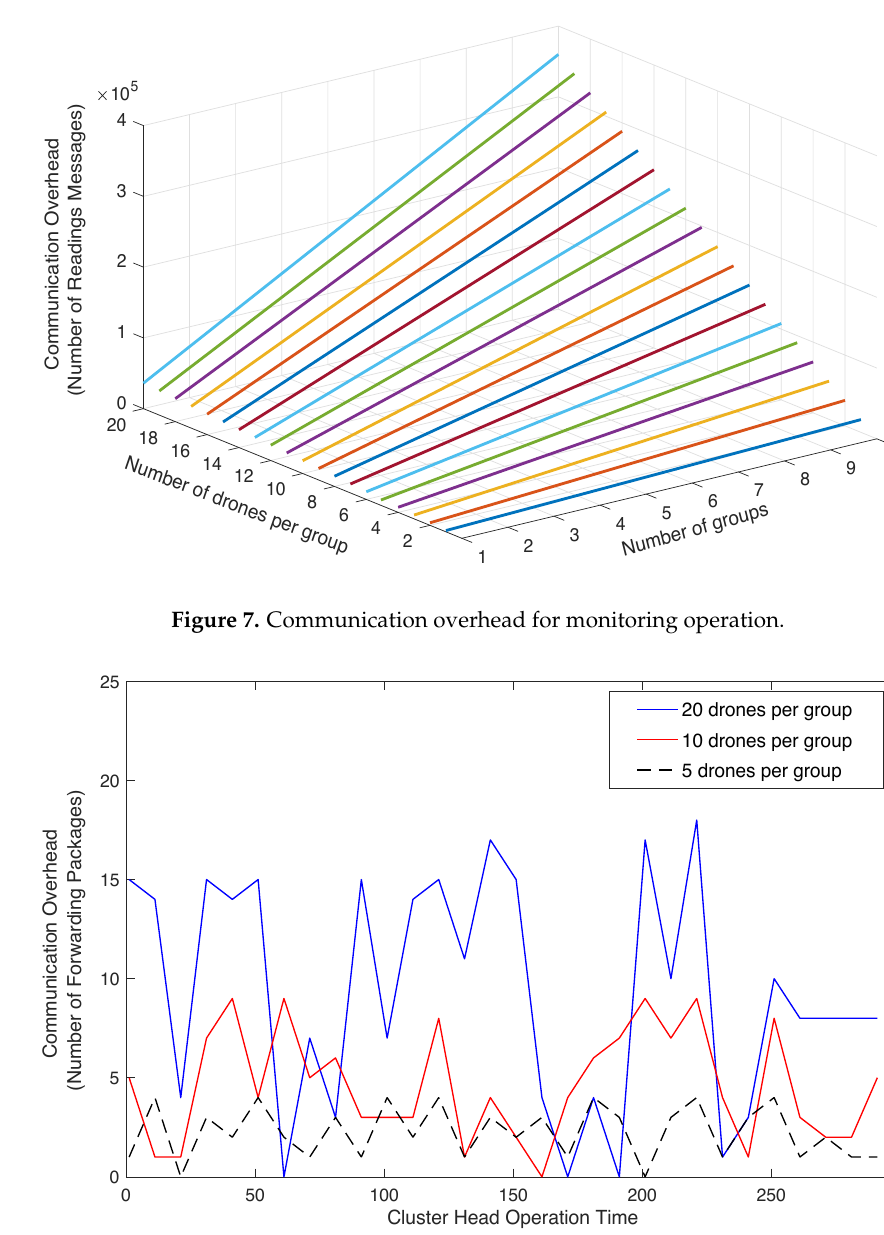
Figure 8. Cluster head communication overhead for the forwarding